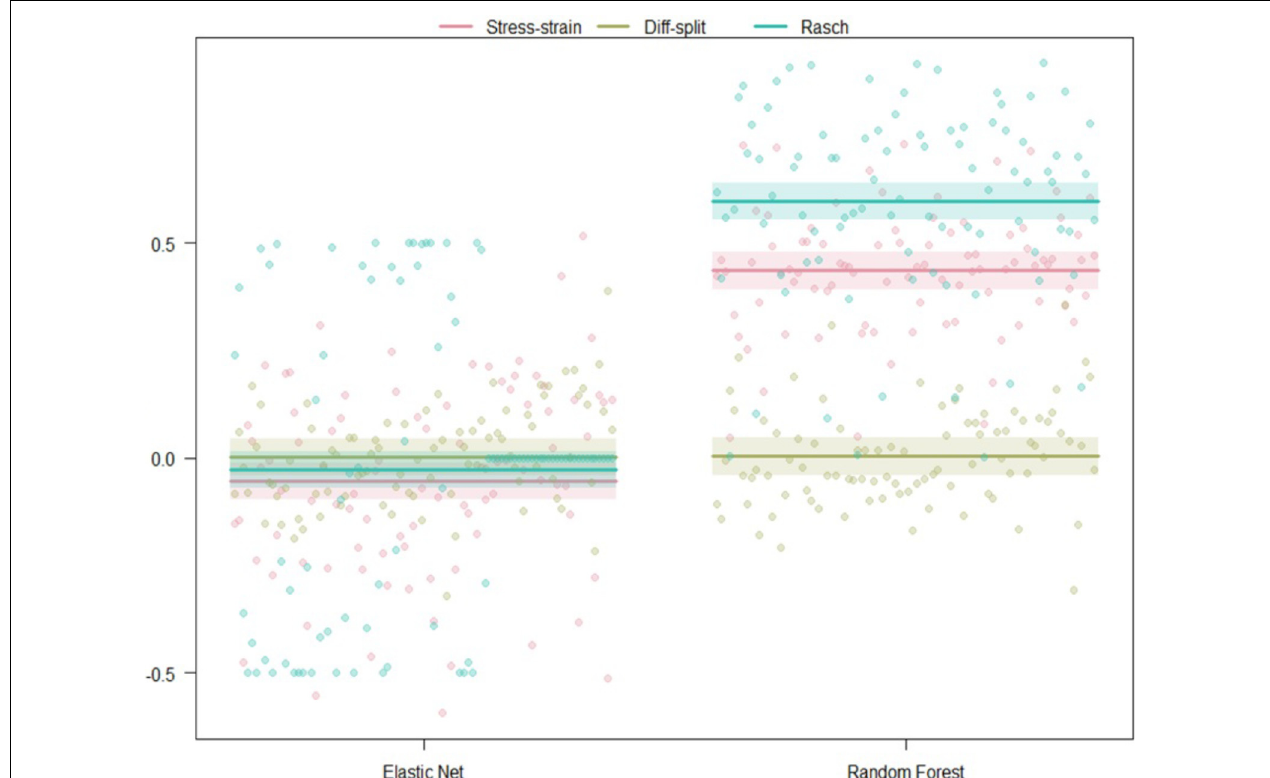
FIGURE 9 | Regression estimates for models trained on the WM task and transferred to the ISR task across labeling technique and machine learning algorithm. Points along the y -axis are GINI Index values for individual folds, lines are the regression estimate, and bars are the error of the